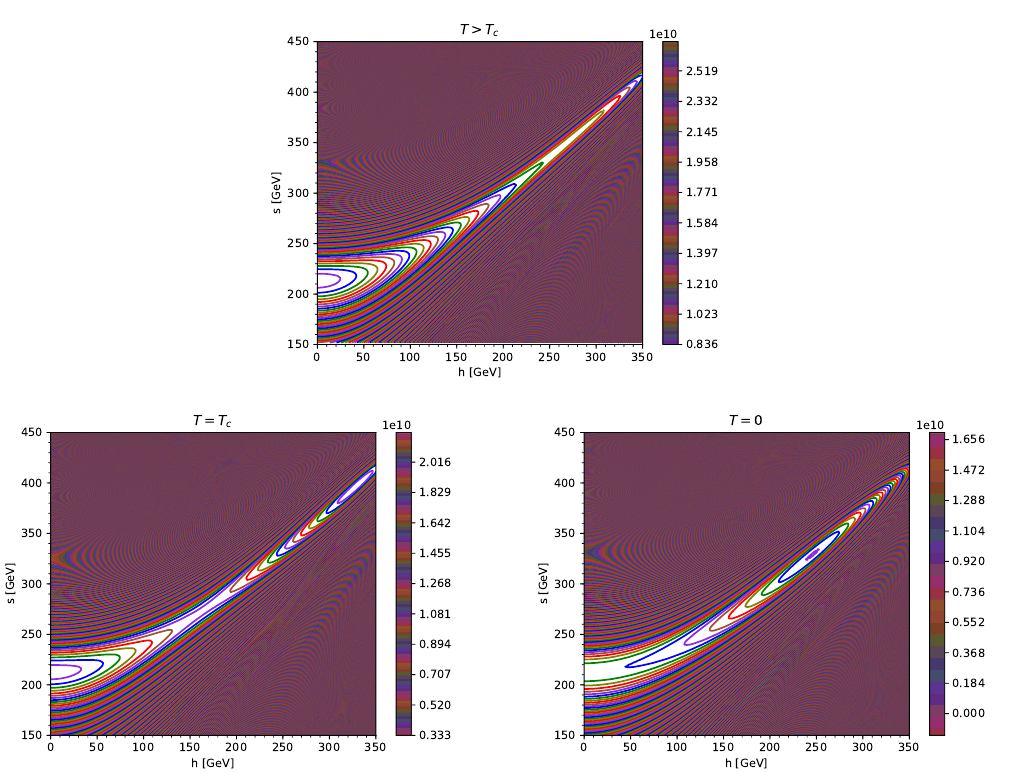
Figure 1 . Contours of total e(cid:11)ective potential in the h (cid:0) s plane, with parameters w = 329 : 2 GeV, m S = 702 : 0 GeV, m (cid:31) = 137 : 1 GeV, and (cid:18) = (cid:0) 0 : 64. From upper plot to lower right plot, the potential is evaluated at temperature T > T c , T = T c , and T =